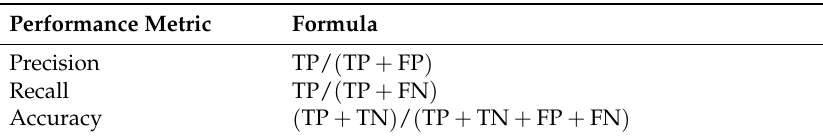
Table 1. Performance metrics for the classification model.